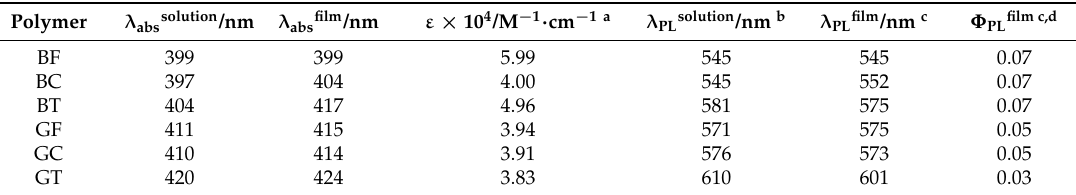
Figure 1. ( a ) Normalized UV–vis absorption spectra of the polymers in CHCl 3 (1.0 × 10 − 5 M); ( b ) normalized photoluminescence spectra of the polymers in the spin-coated thin-film state. Table 2. Photophysical properties of the synthesized polymers.